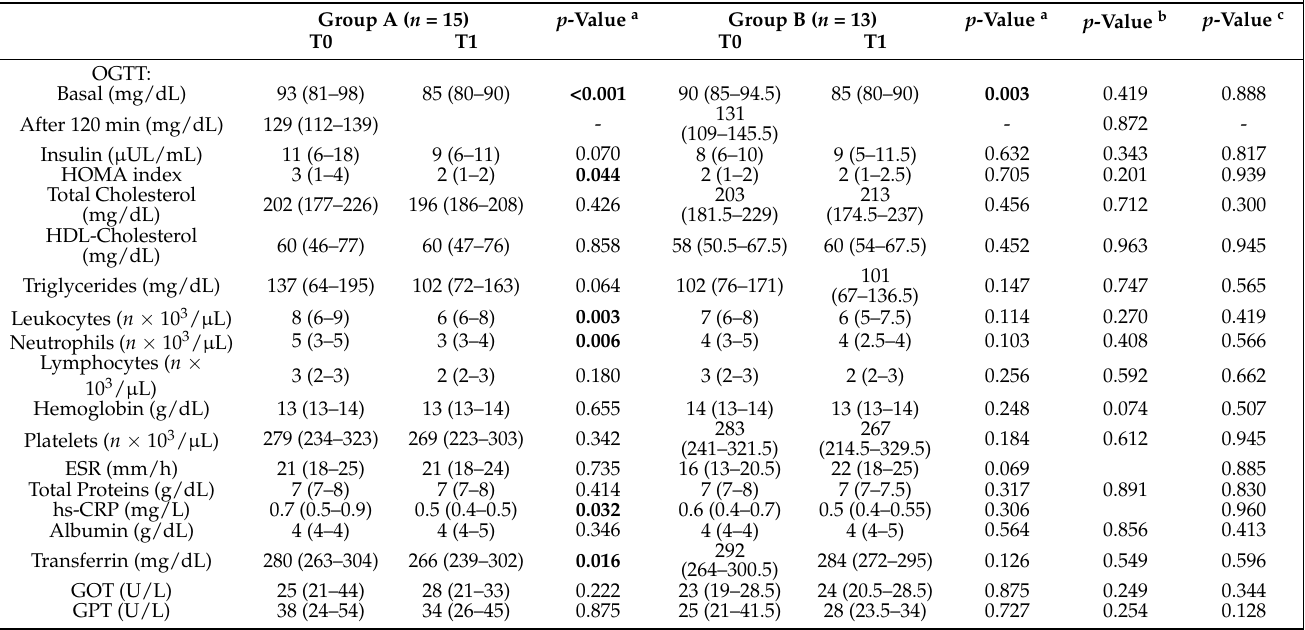
Table 2. Laboratory data of recruited patients in group A and